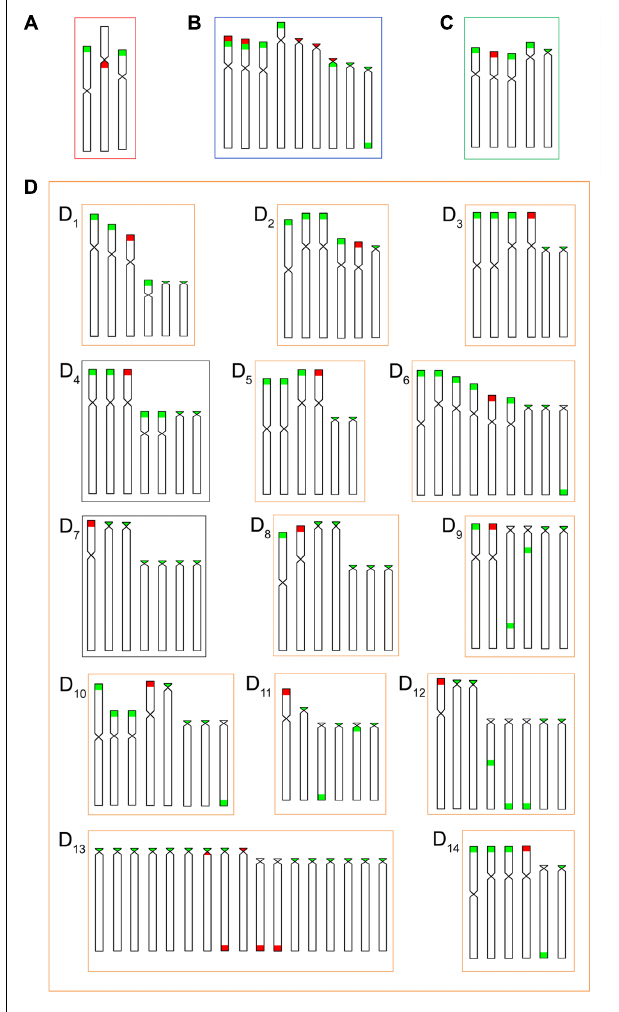
FIGURE 8 | Idiograms for numbers and locations of the 18S (red) and 5S (green) rDNA sequences in the chromosomes of the B. coracoideus populations (A) ESU-A Igarapé Jundiá – Cuieiras River, (B) SEU-B Demini River, (C) SEU-C Igarapé Apeú – Guamá River, and (D) SEU-D 1 − 14 Purus